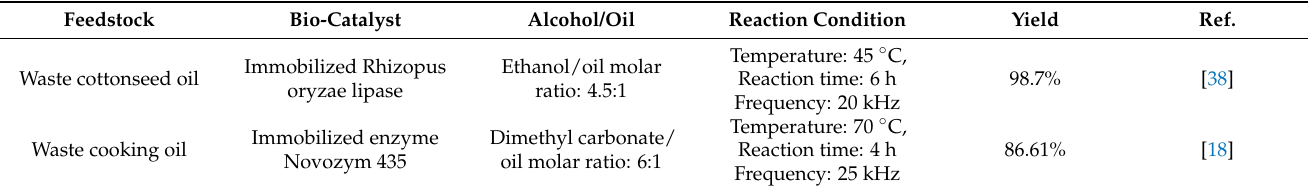
Figure 2. The yield of biodiesel ( a ) Effect of reaction time at temperature 60 ◦ C; ( b ) Effect of tempera- ture 40 ◦ C to 70 ◦ C, respectively. Table 2. Production of biodiesel using ultrasound-assisted biocatalyst transesterification by different